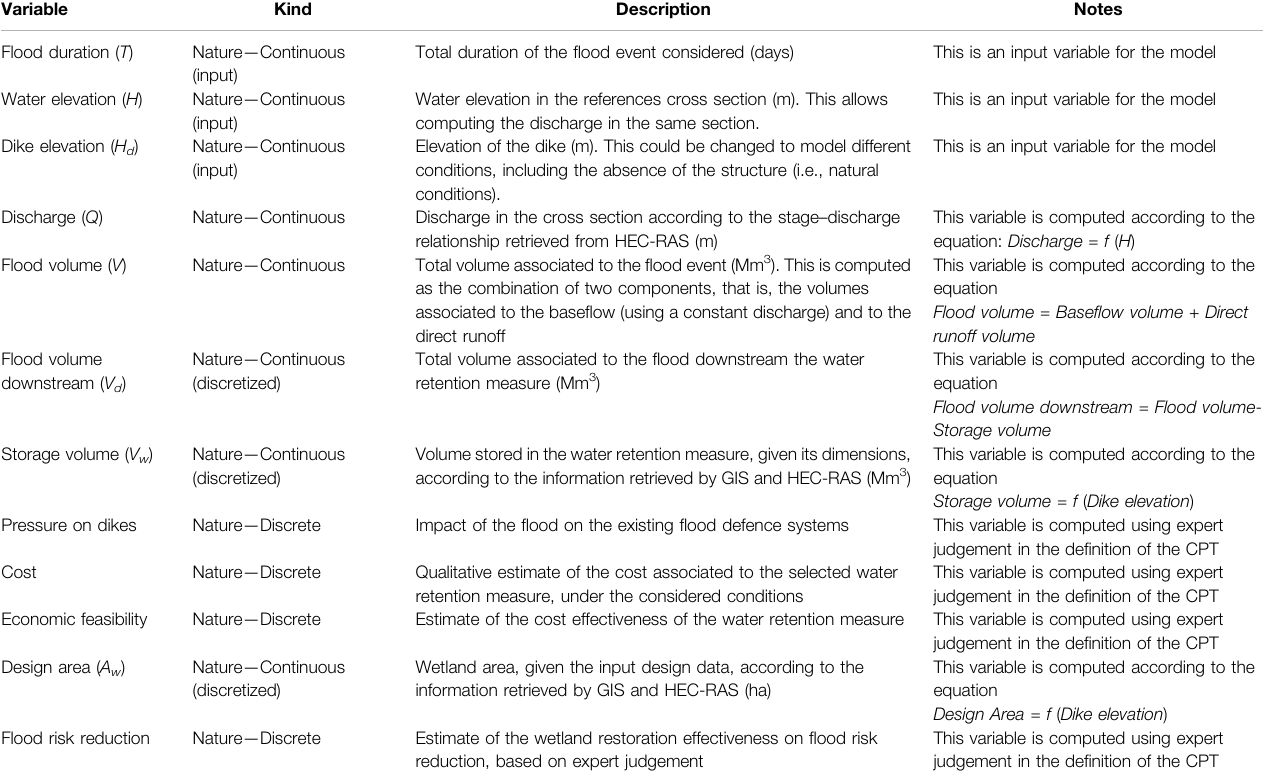
TABLE 1 | Description of the variables used for the fl ood risk assessment in the BBN.